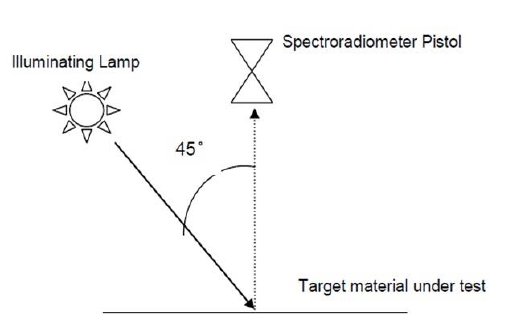
Figure 3. Laboratory setup